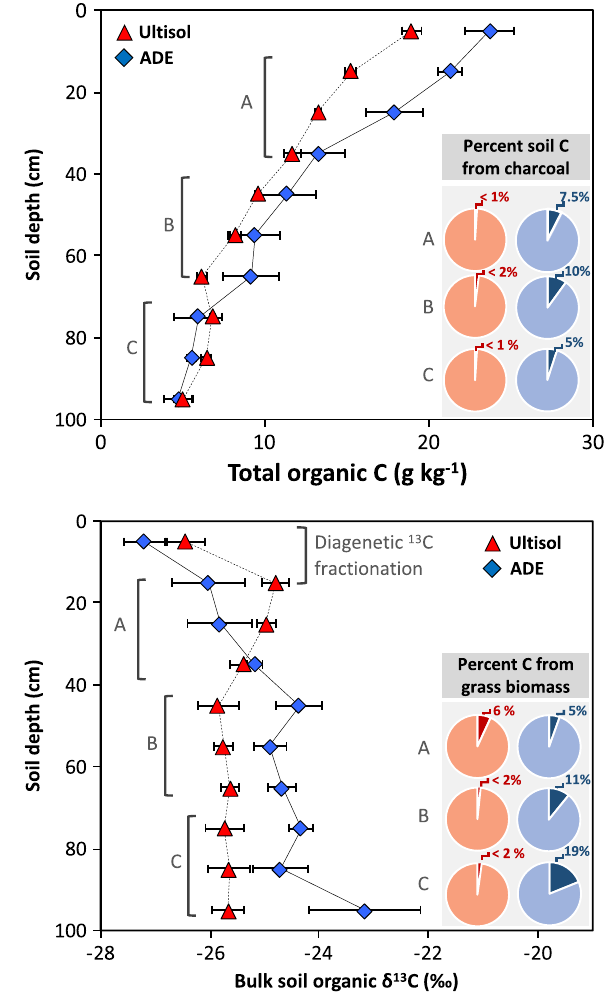
Fig. 4 Concentration of total organic carbon and stable isotope ratios of carbon in bulk organic matter. Stable carbon isotope ratios show an expected enrichment caused by diagenetic fractionation at the topsoil layer for both soil types, followed by a marked shift in isotopic ratios that indicates a signi fi cant contribution of grass biomass to carbon pools at deeper layers of ADE pro fi les, but not for the surrounding Ultisol. Data points show average values and error bars indicate two standard errors of the mean across maximum contrast pro fi les ( n = 5 for ADE and n = 5 for Ultisol for each 10cm depth; Fig. 1). Inset panels depict the average per cent fraction of pyrogenic charcoal and grass-derived biomass in the total carbon pool (Eqs. 1 and 2) between 10 to 40cm (A), 40 to 70cm (B), and 70 to 100cm (C) depths. Data are shown in Supplementary Fig.